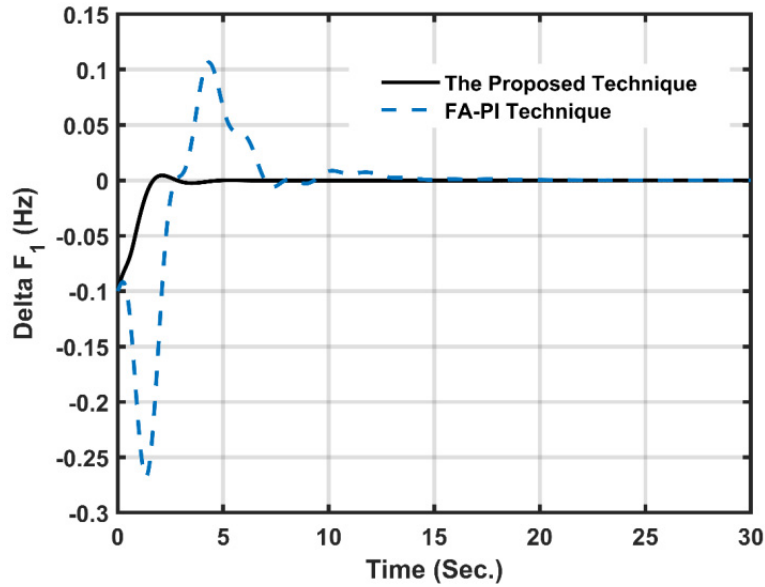
Figure 18. Frequency deviation in area 1 under disturbances in thermal and PV demands.